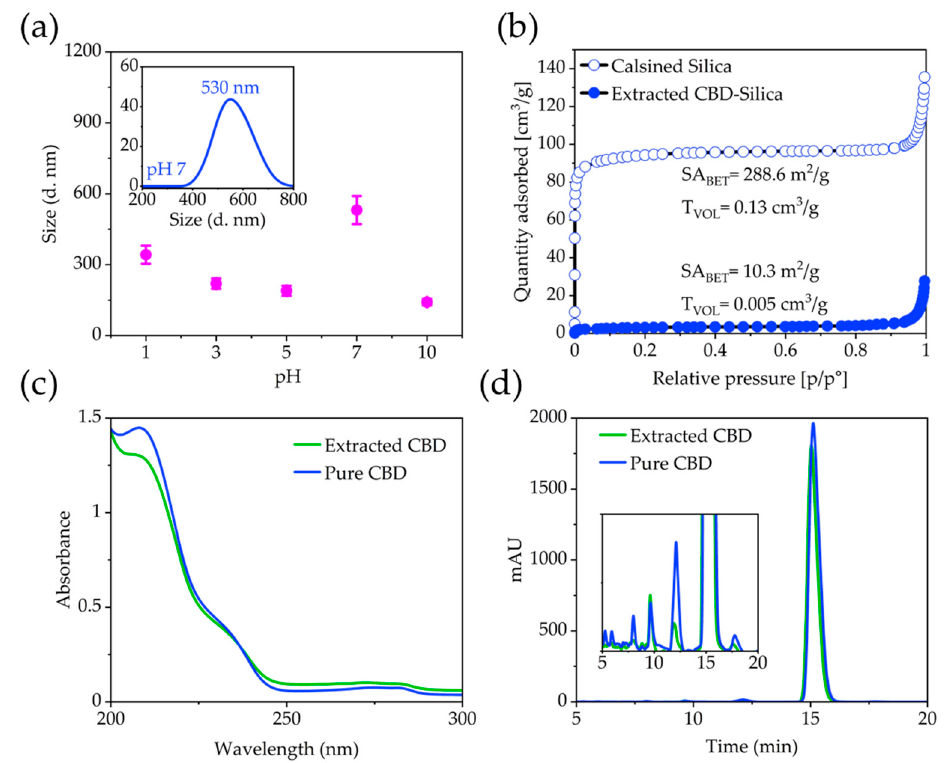
Figure 2. ( a ) DLS measurements conducted on CBD-Silica after 10 min sonication as a function of pH. Inset shows the measurement performed at pH 7. ( b ) N 2 adsorption isotherms of extracted and calcined silica samples. Comparison of pure CBD and CBD extracted from silica. ( c ) UV-Vis spectra of pure and extracted CBD showing the characteristic absorption maximum at 210 nm. ( d ) Chromatograms of pure and extracted CBD showing a good correlation in the retention time.